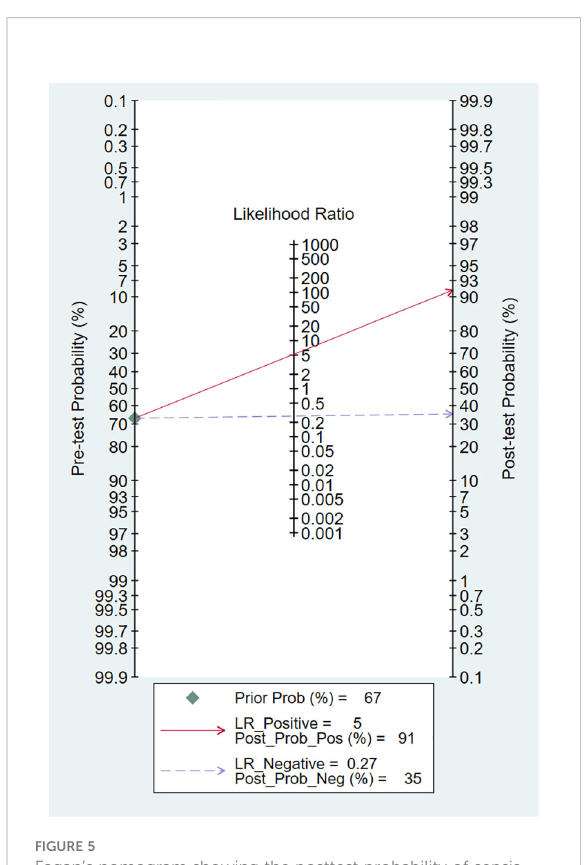
FIGURE 5 Fagan ’ s nomogram showing the posttest probability of sepsis.